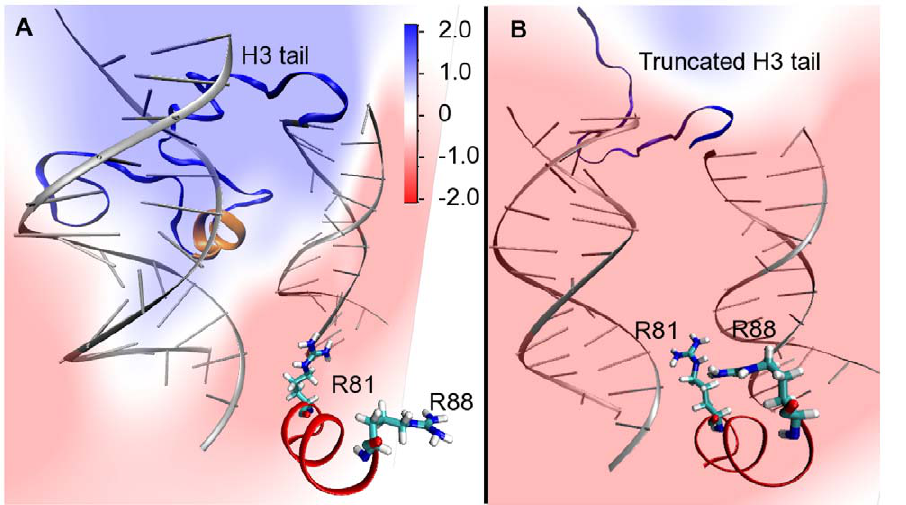
Figure 10. Electrostatic potential maps of DNA and H3 N-terminal tail as seen by Arg81 and Arg88. Potential is color coded (in units of Volts) as shown in the scale. (A) Snapshot from the intact nucleosome trajectory showing that in presence of the H3 N-terminal tail Arg81 and Arg88 points away from the DNA surface. The location of the a -helix in H3 tail is shown in orange ribbons. (B) Snapshot from the H3 tail truncated simulation showing the Arg81 and Arg88 sidechain pointing towards the DNA in the absence of the H3 tail.